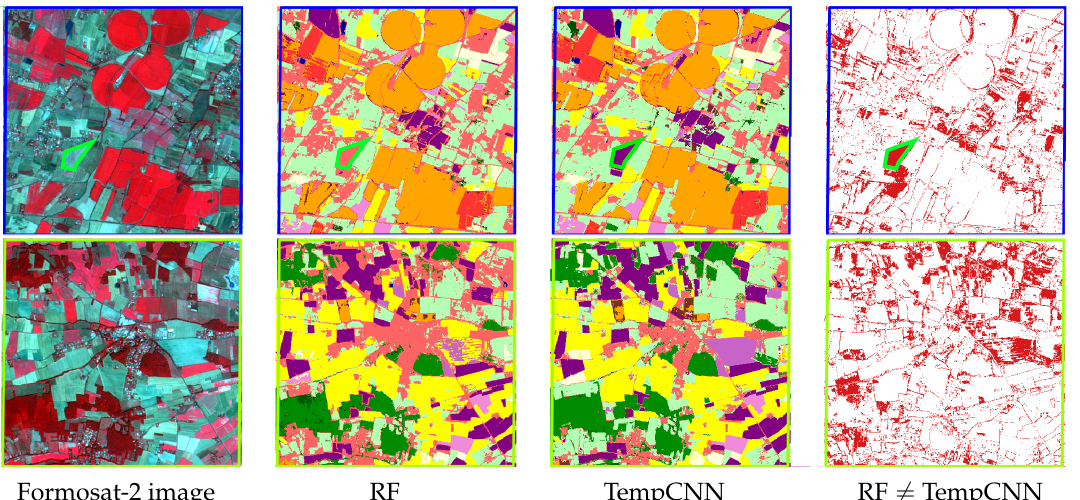
Figure 11. Visual results for two areas. The first column displays the Formosat-2 image in false color from 14 July 2006. The second and third columns give the results for Random Forest (RF) and our TempCNN model, respectively. The images in the last column displays in red the disagreement between both classifiers. Legend of land cover maps is given in Table